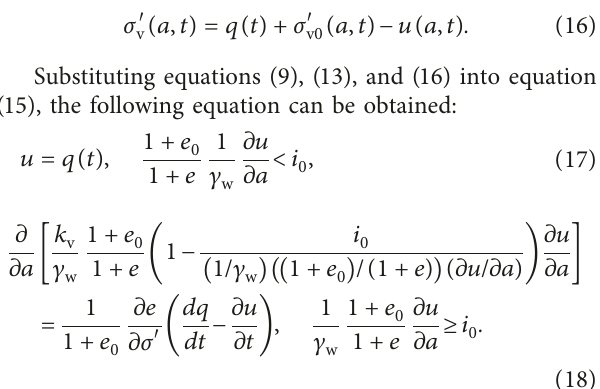
Figure 4: Time-dependent